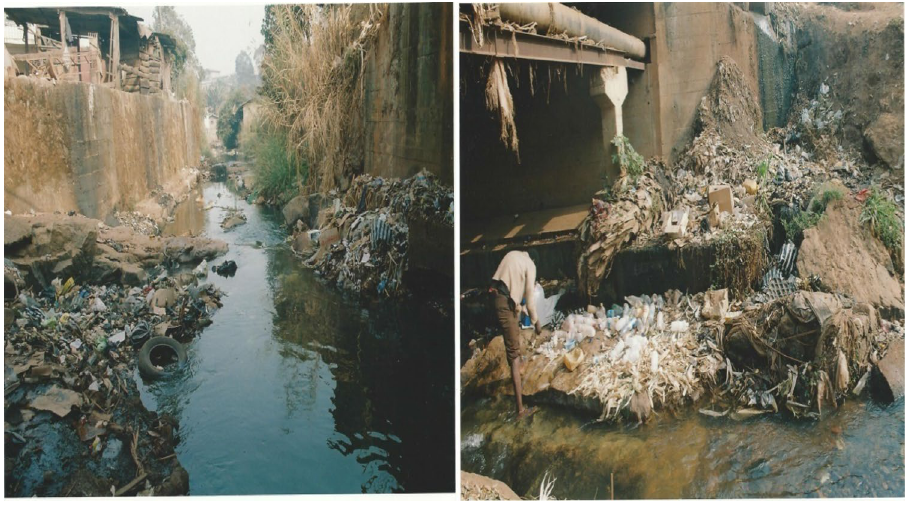
Fig. 10 Refuse dumped at some sampling points in the Mezam River